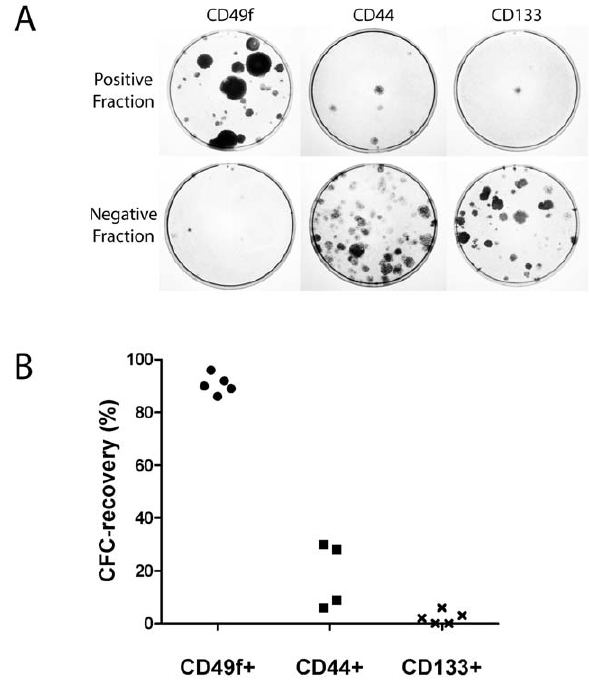
Figure 6. CFC-recovery following CD49f + , CD44 + , and CD133 + selection, in advanced prostate cancer. [ A ] A representative monolayer colony-formation assay arising from positive and negative fractions of putative markers is shown. Amongst the positively selected fractions, the greatest numbers of colonies is found in the CD49 + fraction. [ B ] CD49f + selection recovers the largest number of monolayer-CFCs.